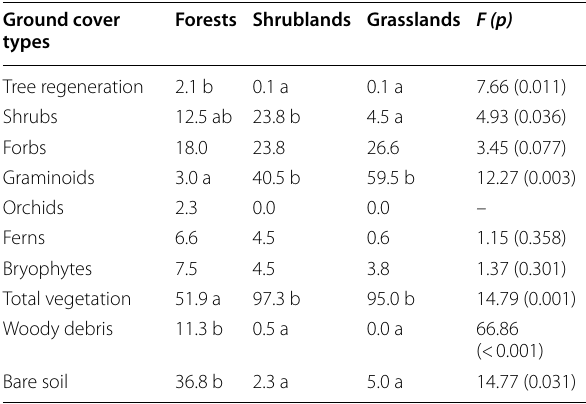
Table 1 ANOVAs of ground cover (%) for different vegetation types, where plants were discriminated by life forms